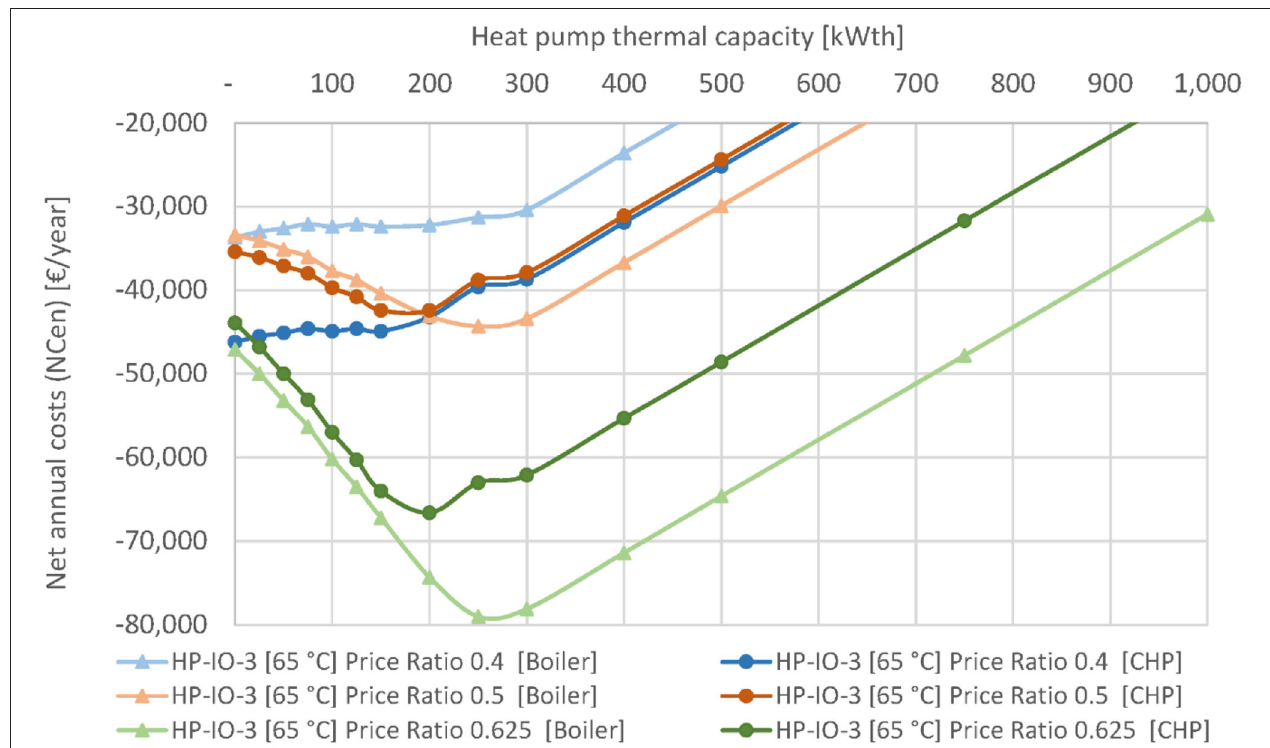
FIGURE 10 | Net annual costs ( NC En ) of the HP-IO-3 (both with 65 ◦ C) at three different price ratios and biogas utilization in either biogas boiler or biogas CHP. Negative net annual costs are net annual